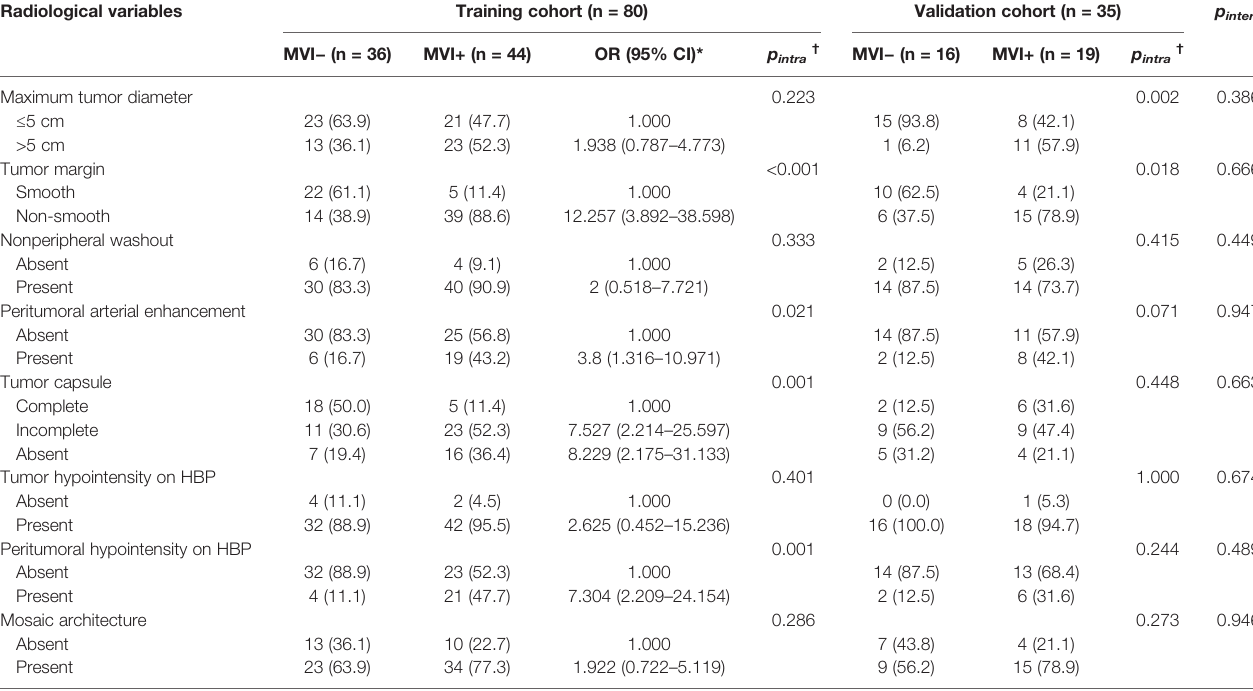
TABLE 2 | Radiological features in the training and validation cohorts. Radiological variables Training cohort (n = 80) Validation cohort (n = 35)